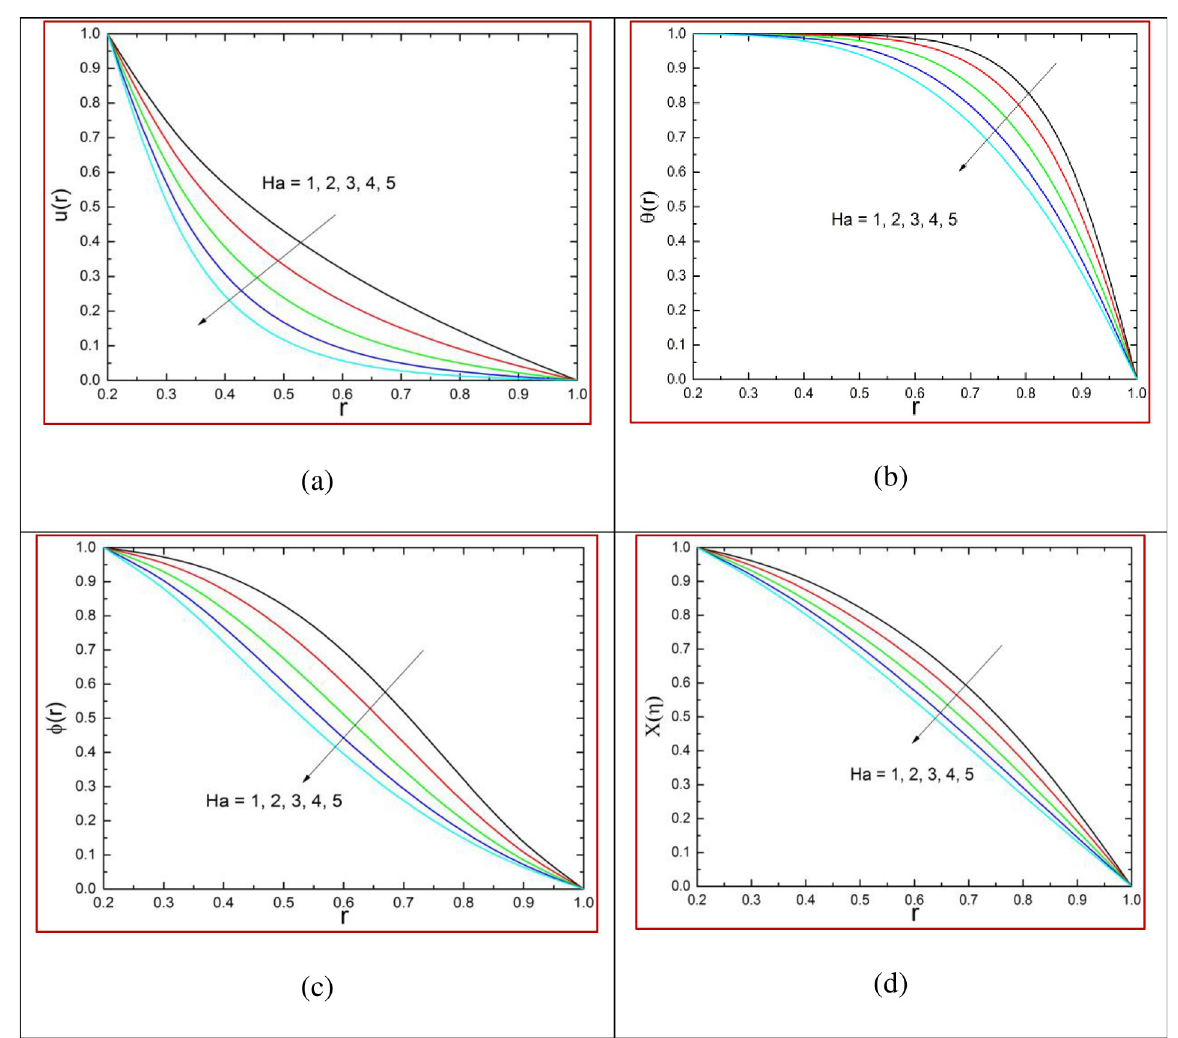
Fig 3. The impact of Hartmann number on the fluid